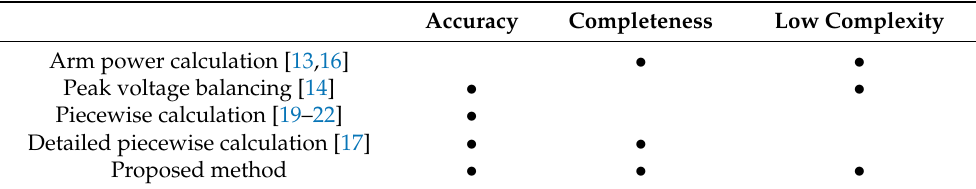
Table 3. Comparison table of different methods. Accuracy Completeness Low